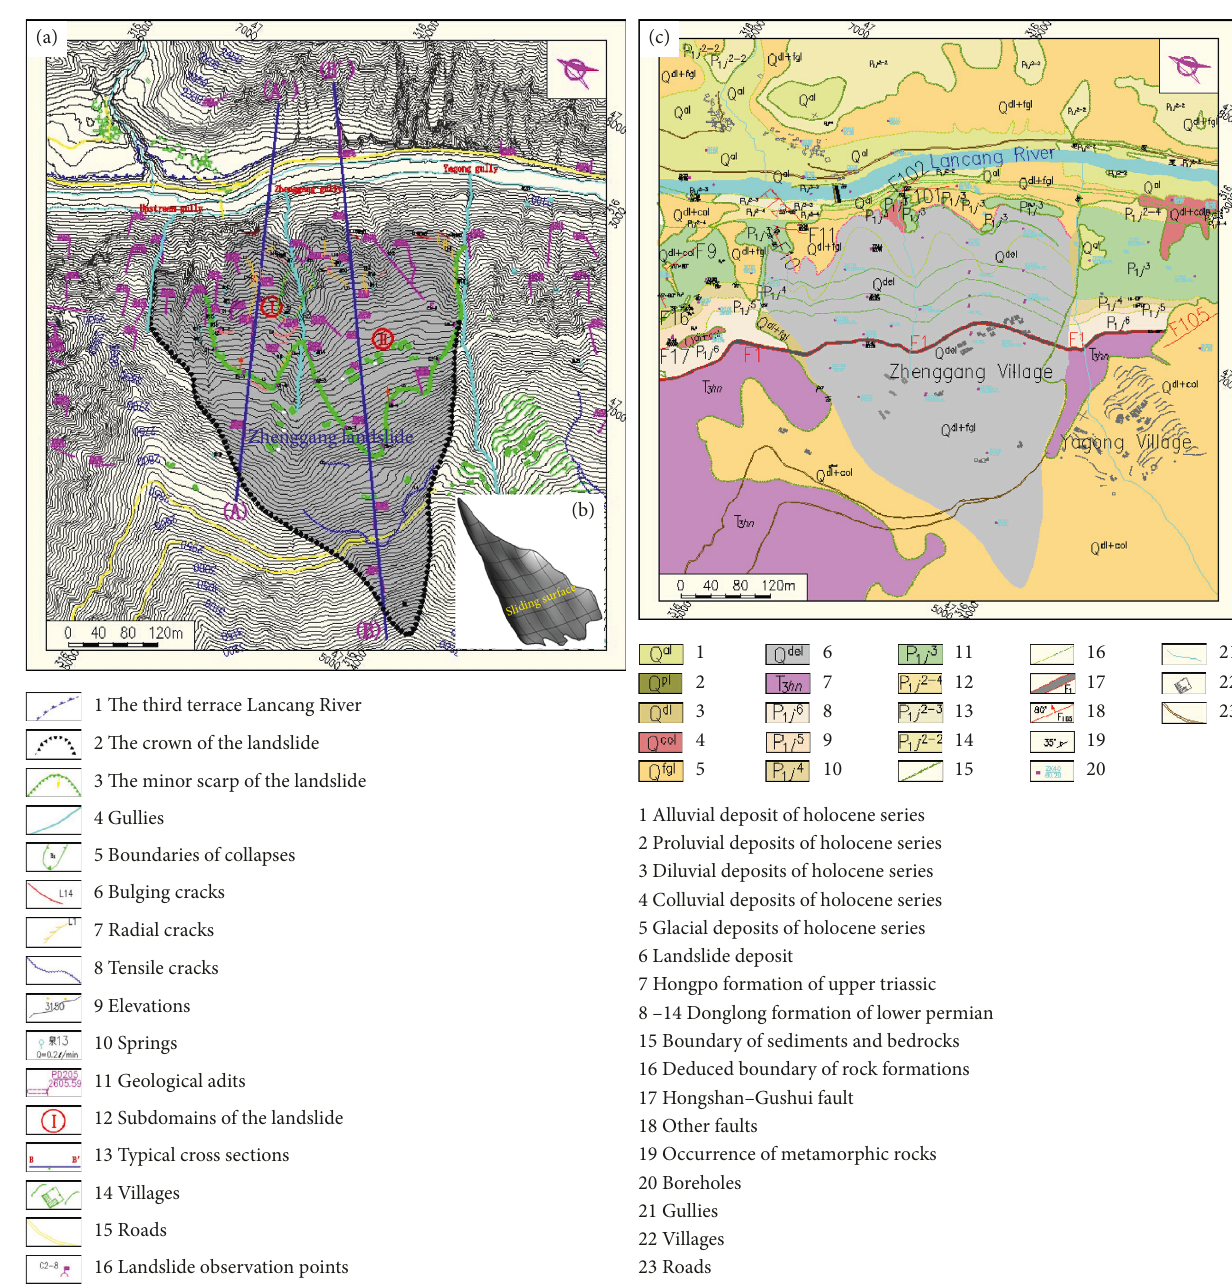
Figure 4: The engineering geological map of the Zhenggang